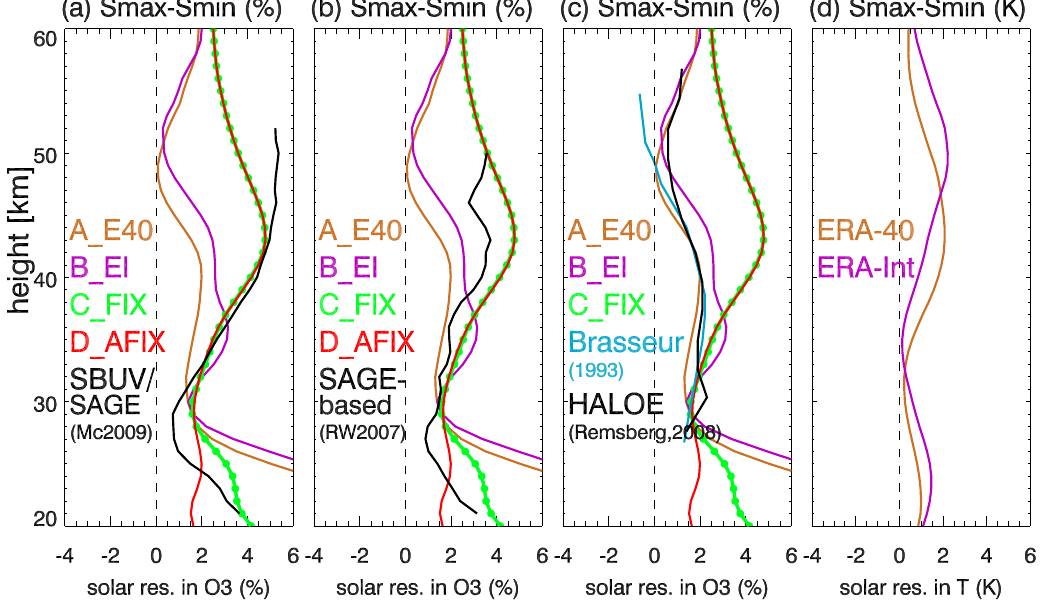
Fig. 5. (a) – (c) Composite analysis (solar max minus solar min) of the simulated ozone response (in %) from runs A E40 (orange line), B EI (violet line), C FIX (green line) and D AFIX (red line) in tropics (25 ◦ S–25 ◦ N). Also shown is the estimated solar response from (a) SBUV/SAGE (McLinden et al., 2009), (b) SAGE-based (Randel and Wu, 2007), and (c) the Brasseur (1993) 2-D model (light blue) and HALOE data from Fig. 12 of Remsberg (2008) (black). (d) shows the similar composite analysis for temperature (K) from ECMWF ERA-40 and ERA-Interim